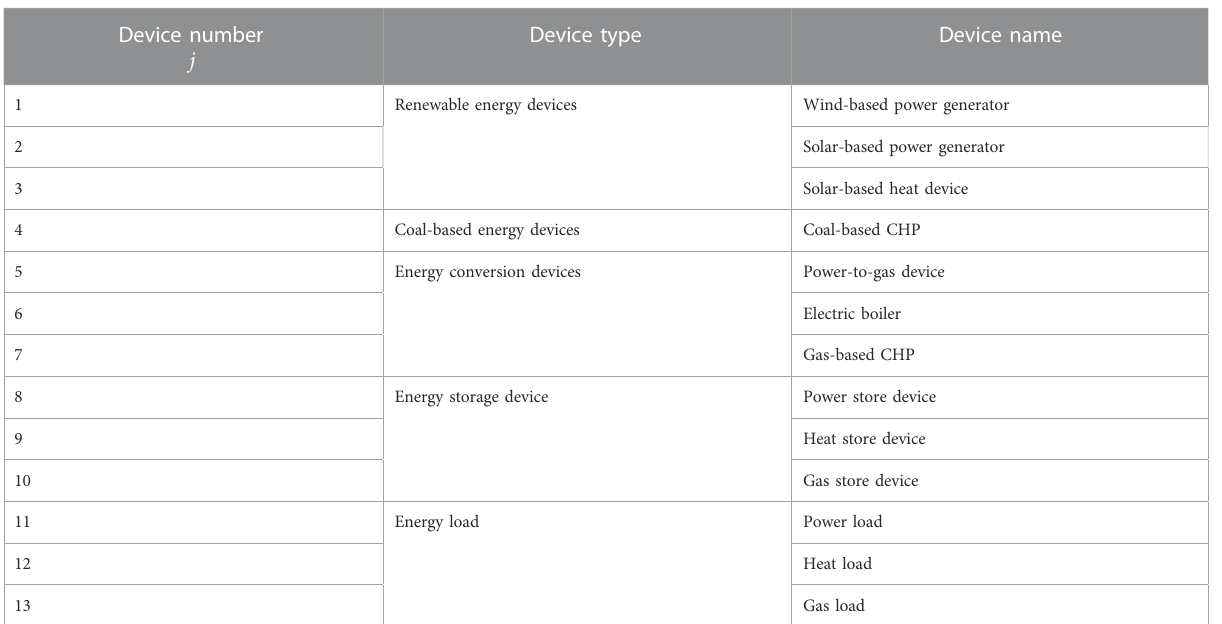
TABLE 3 Devices in each